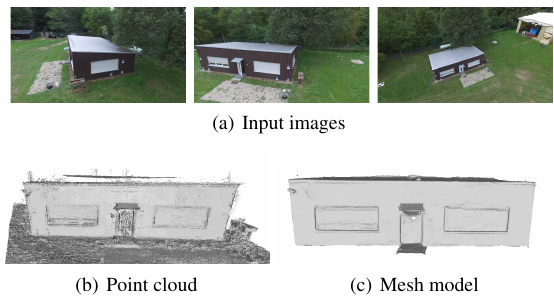
Figure 5. The rate of success for known and unknown intrinsic camera